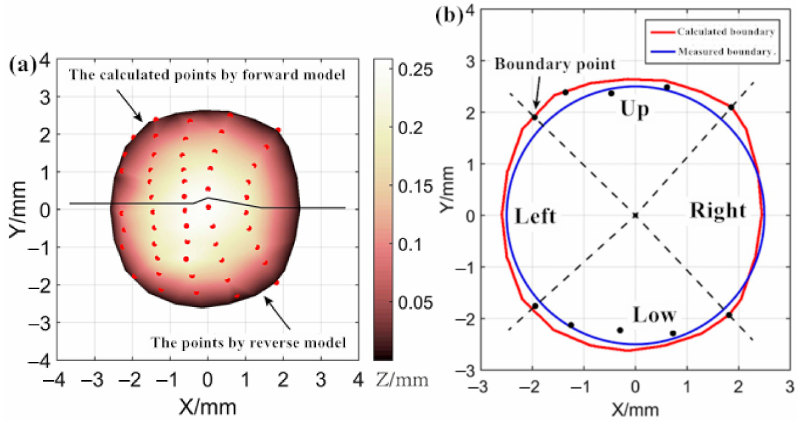
Figure 17. The optimization results of the weld pool surface in Figure 2a. ( a ) The weld pool surface after boundary optimization and the forward-reverse united reconstruction optimization method; ( b ) the boundary comparison between the measured weld and the reconstructed weld pool surface.